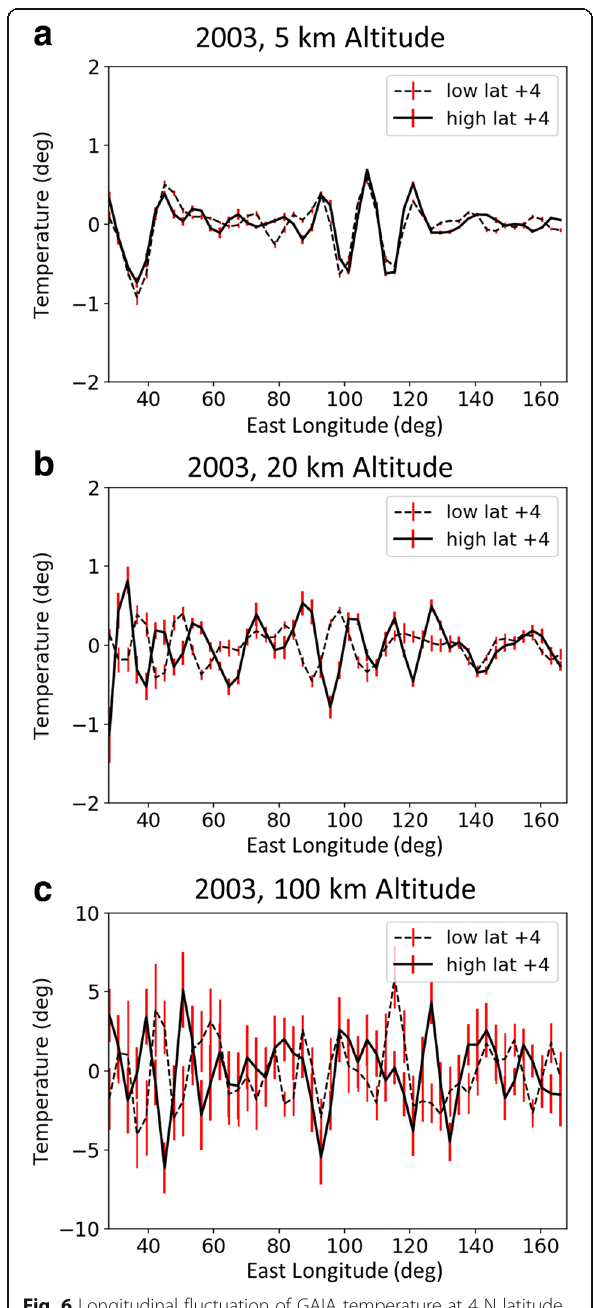
Fig. 6 Longitudinal fluctuation of GAIA temperature at 4 N latitude in the same format as Fig. 5. All data are for 2003, but at different altitudes: a 5 km, b 20 km, and c 100